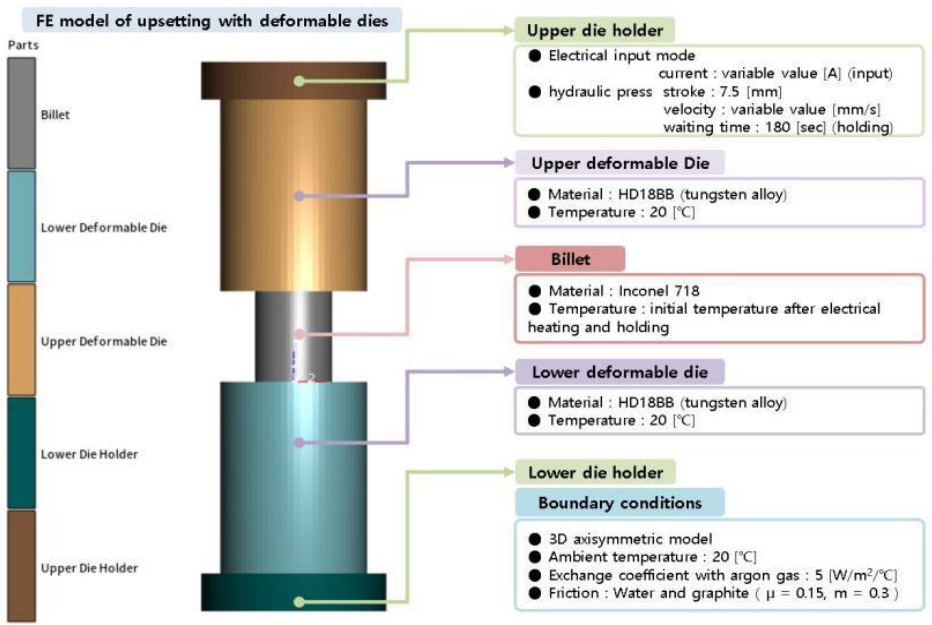
Figure 6. Conditions related to deformable dies for the Joule heating, heat transfer, and deformation analyses.